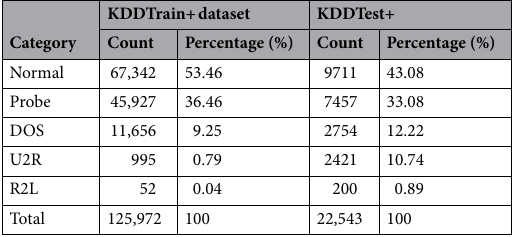
Table 1. Distribution of five major categories of behaviours.